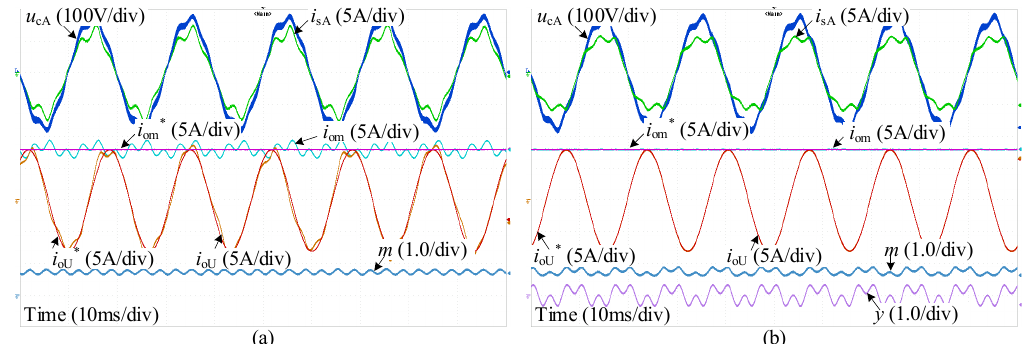
Figure 9. Experimental results with the proposed modulation scheme under disturbed input condition: ( a ) without the proposed feedback control strategy; ( b ) with the proposed feedback control strategy.